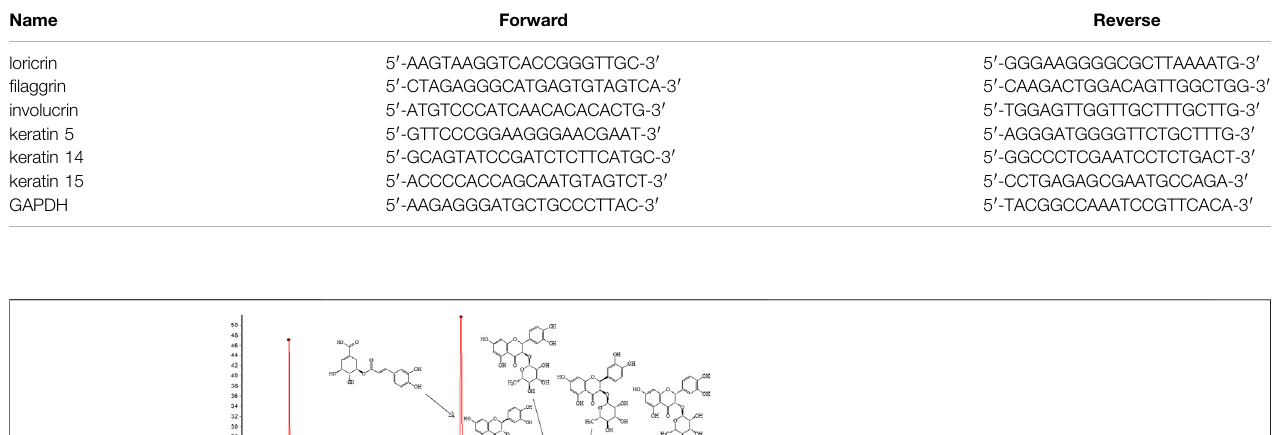
TABLE 2 | Sequence of primers.